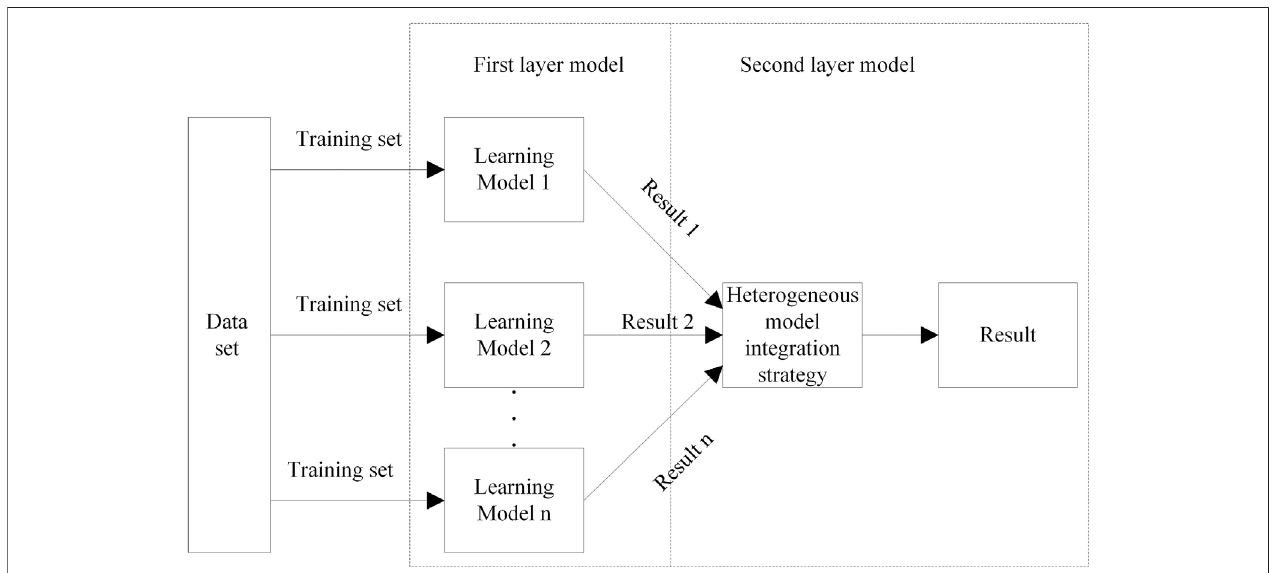
FIGURE 5 | Heterogeneous model ensemble learning